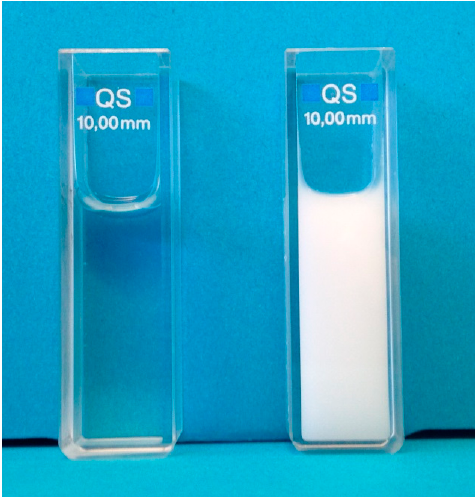
Figure 3. Photograph of aqueous 3 wt. % HPC sample below switching temperature ( left ), above switching temperature ( right ).